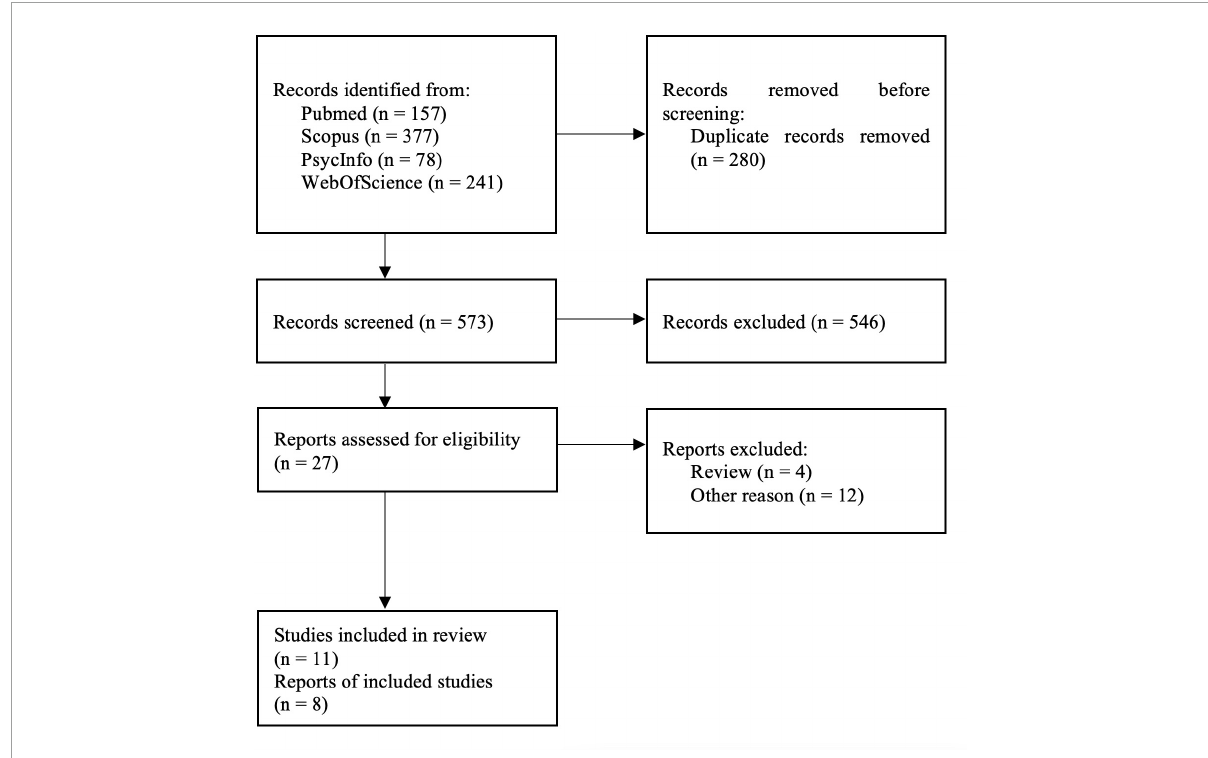
FIGURE1 PRISMA flowchart showing the inclusion of studies for the meta-analysis (Moher et al.,